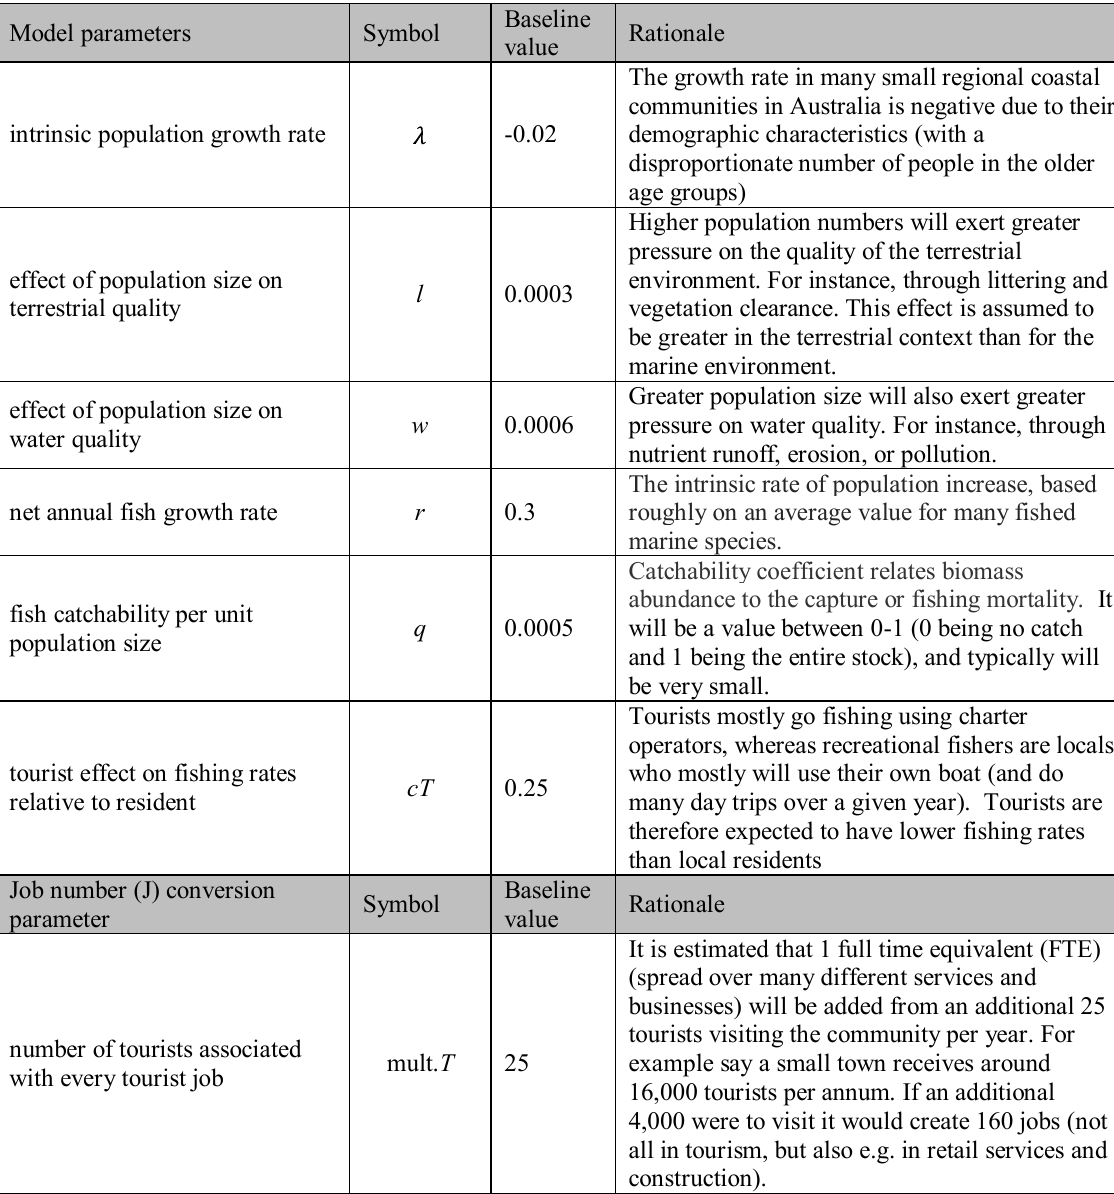
Table A1.3: Model parameters, baseline values, and rationale for the